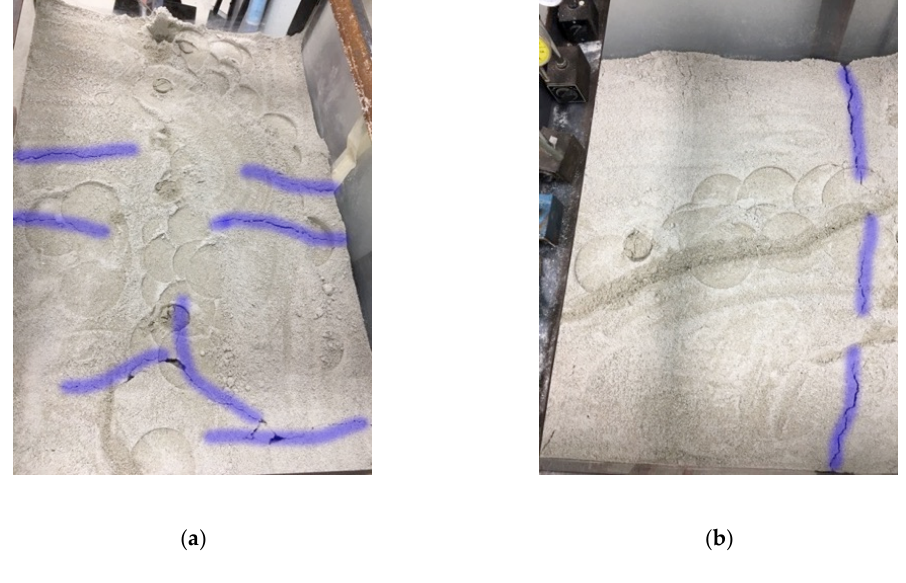
Figure 9. Fractures in ( a ) F27R ( b ) F39R.